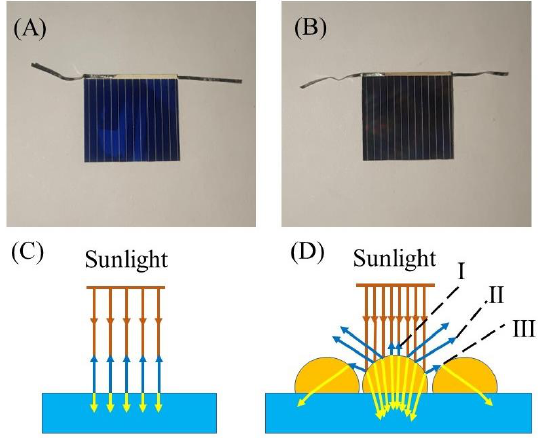
Figure 7. Photographs of the solar cells ( A ) without photoresist film MLAs and ( B ) with the photoresist film MLAs, and the light path of the incident sunlight on ( C ) a bare solar cell and ( D ) a solar cell with the photoresist film MLAs and three kinds of reflected light ( Ⅰ , Ⅱ , Ⅲ ).